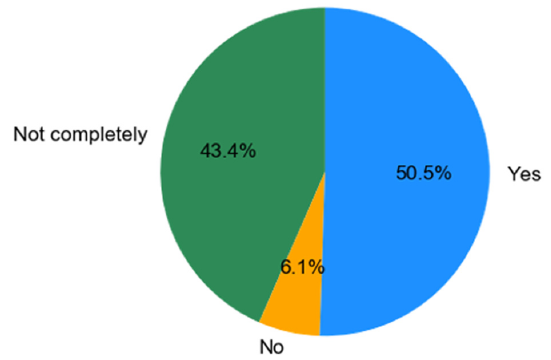
Figure 2. Pie chart representing answers from Q1.2. Participants were able to select only one answer.